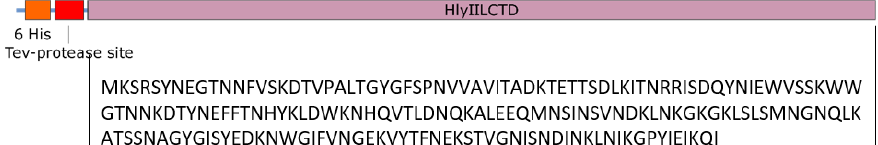
Figure 7. Amino acid sequence of HlyIILCTD from B. cereus ATCC 14579 (M225-I412, according to the full length of the HlyII toxin [7]).